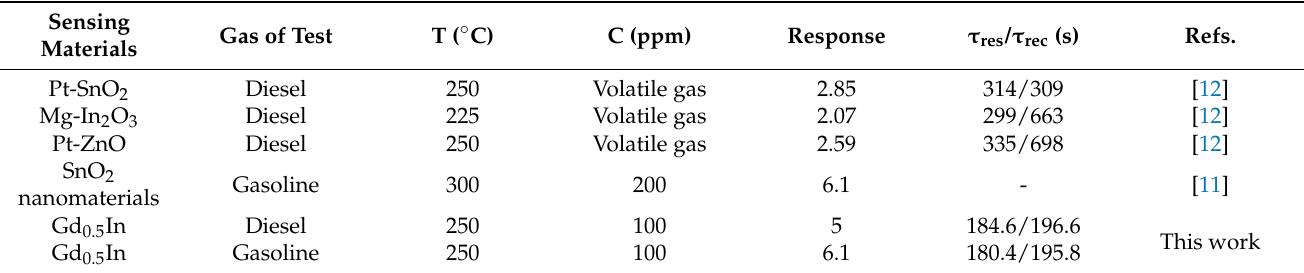
Figure 9. Repeatability and long-term stability of Gd 0.5 In gas sensors for gasoline and diesel volatiles. ( a ) Continuously test the reversible cyclic curves of the three response processes; ( b ) long-term stability tests within 50 days. Table 2. Compared with the properties of volatile sensing materials for gasoline and diesel reported in previous